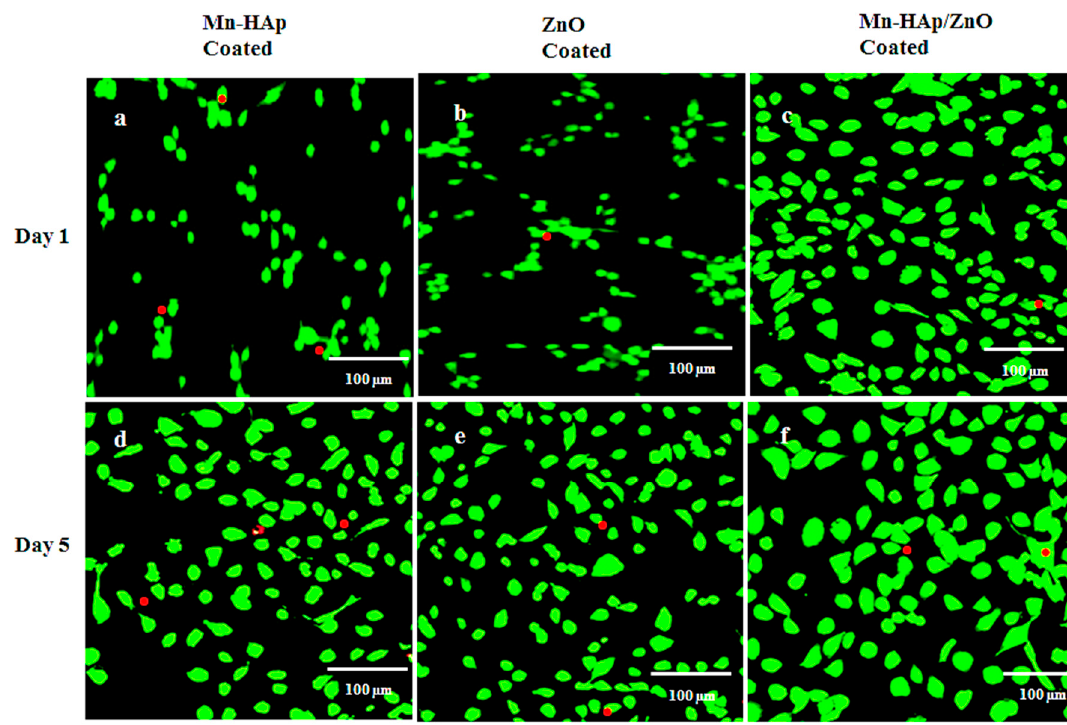
Figure 13. ( a – f ) Live/dead cell analysis of ( a , d ) Mn-HAp, ( b , e ) ZnO, and ( c , f ) Mn-HAp/ZnO bilayer coating on 316L SS at 1 and 5 days of culture. Red color—dead cells, Green Color—Live Cells.